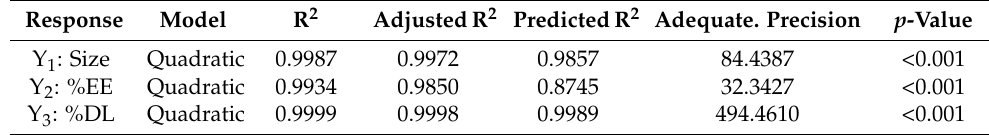
Table 3. The regression analysis of 3-level 3-factor CCD of finasteride-loaded